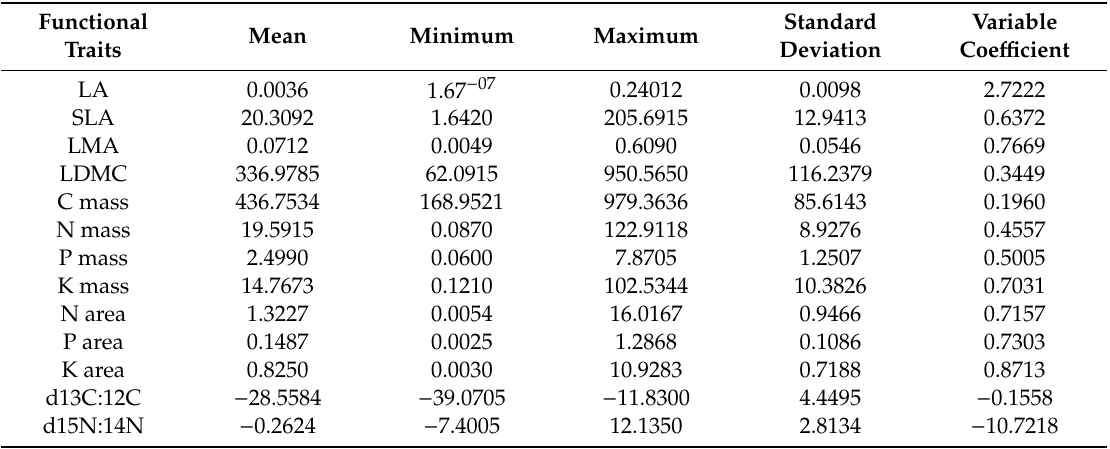
Table 1. Summary statistics of functional traits across China’s di ff erent climates and